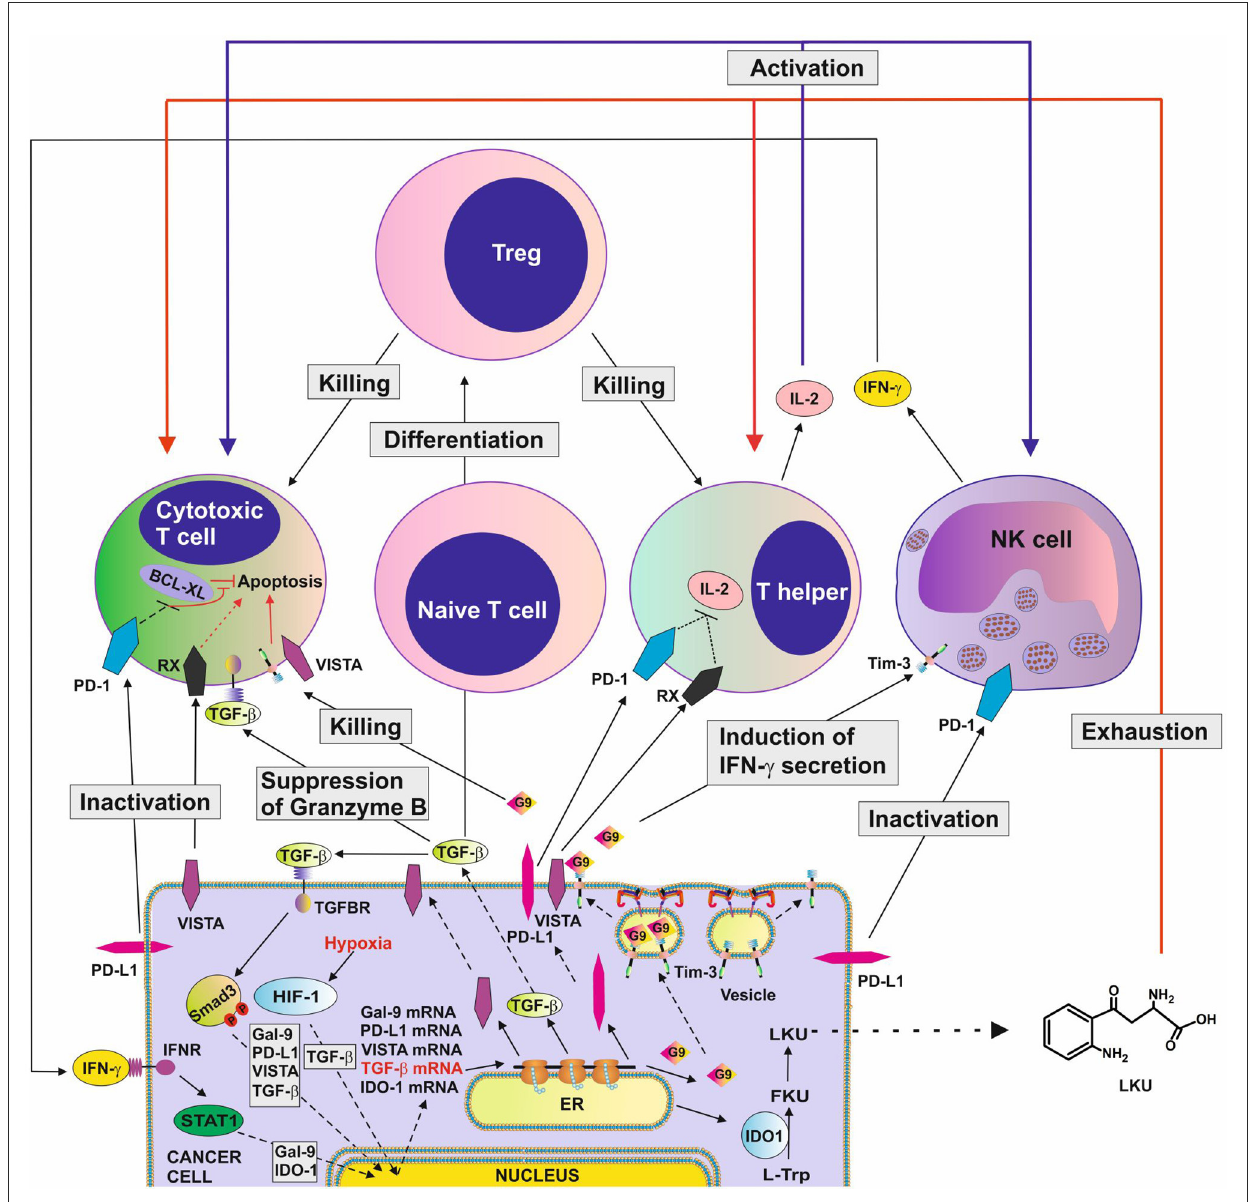
FIGURE1 Complex immune evasion machinery operated by cancer cells. This scheme highlights how several immune evasion pathways could cross-link to potentiate anti-cancer immune evasion. The scheme is based on recent discoveries in the field and shows the complexity of the process. G9, galectin-9; RX, receptor for VISTA which remains to be identified; TGFBR ,receptor(s) for TGF- β ; HIF-1, hypoxia-inducible factor, which controls adaptation of cancer cells to low oxygen availability (physiological environment for malignant tumor growth) and angiogenesis; BCL-XL, a group of anti-apoptotic